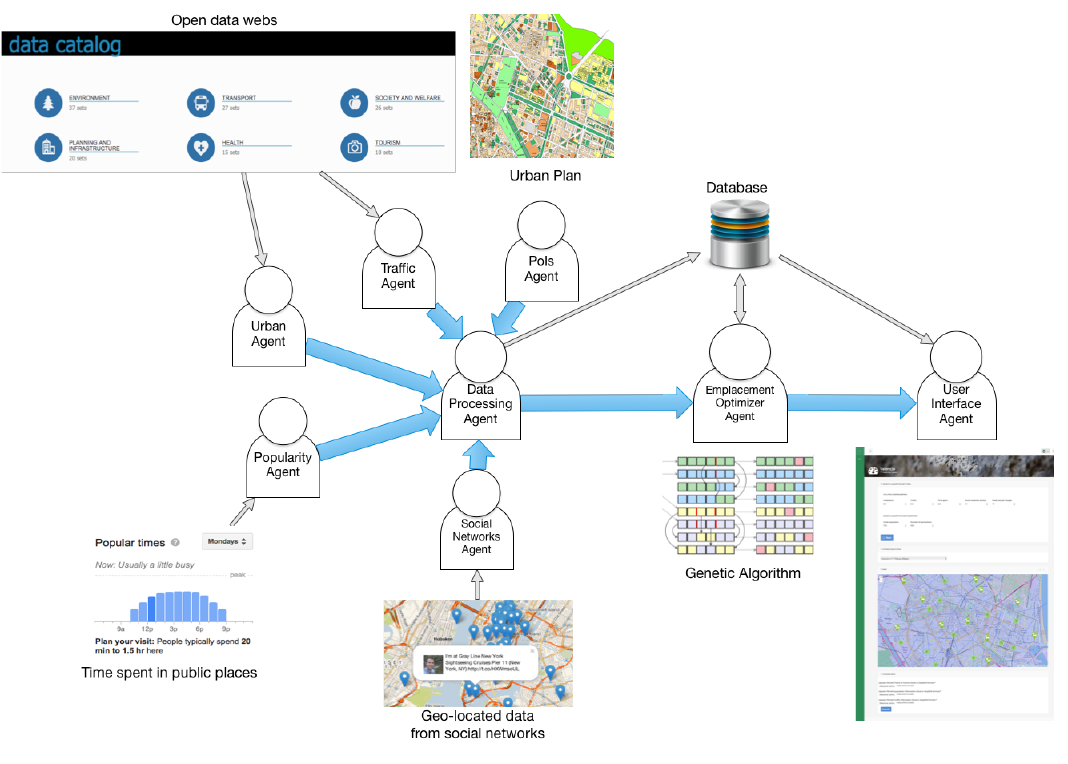
Figure 1. Modules that comprise the tool. PoIs: points of